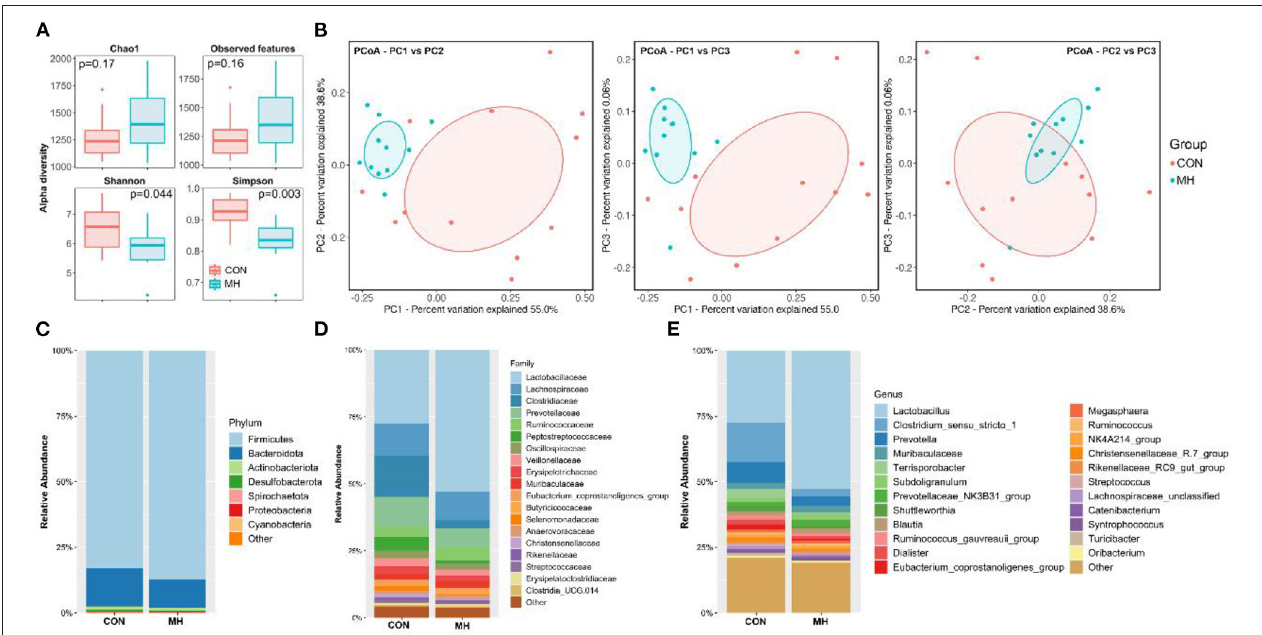
FIGURE 2 | Fecal microbiota richness and evenness, difference of microbiome structure on β -diversity, and relative abundance of microbiota at phylum, family, and genus level. (A) Comparison of α -diversity indices, (B) comparison of β -diversity based on Principal coordinate analysis (PCoA), relative abundances at (C) phylum (D) family, and (E) genus levels. CON = basal diet without any additives, MH = basal diet + 8.3 × 10 9 CFU/kg LM1, n = 12 in the CON group, n = 11 in the MH